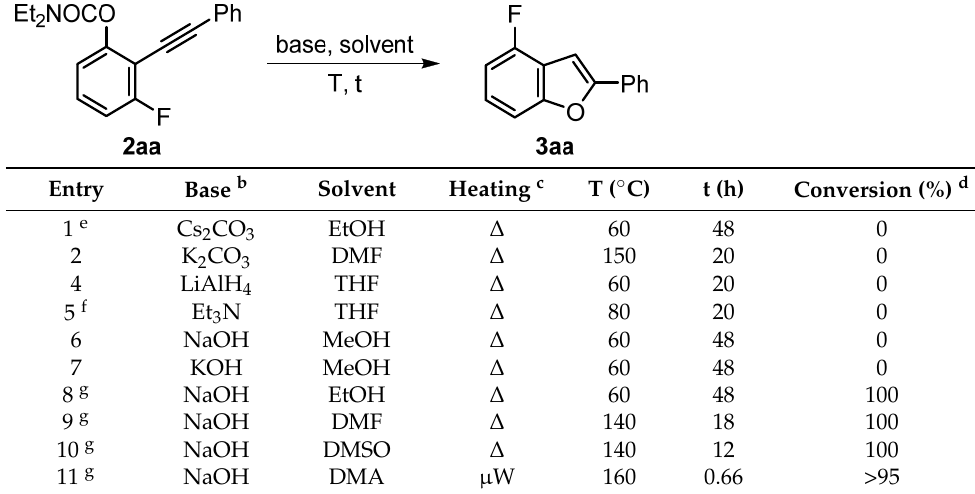
Table 2. Optimization of the hydrolysis–cyclization reaction of 2aa a .